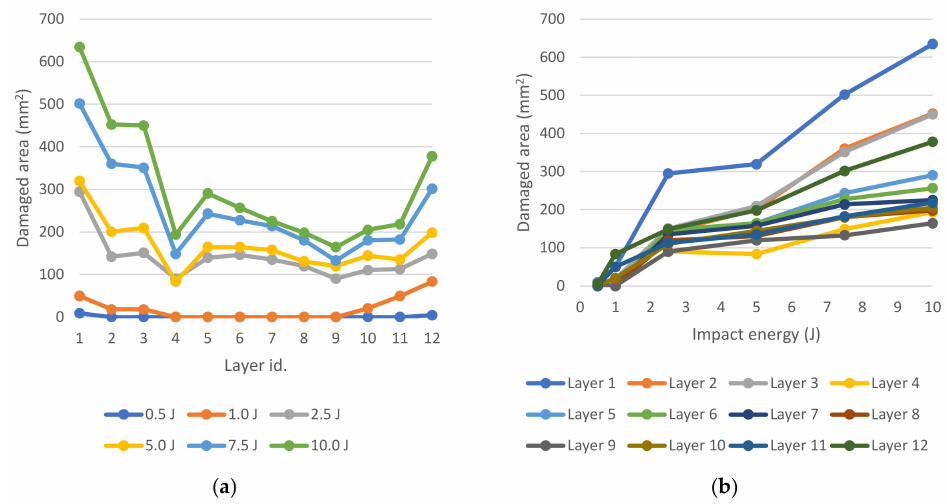
Figure 21. Ply damage distribution; Damaged area vs. layer ( a ); Damaged area vs. impact energy ( b